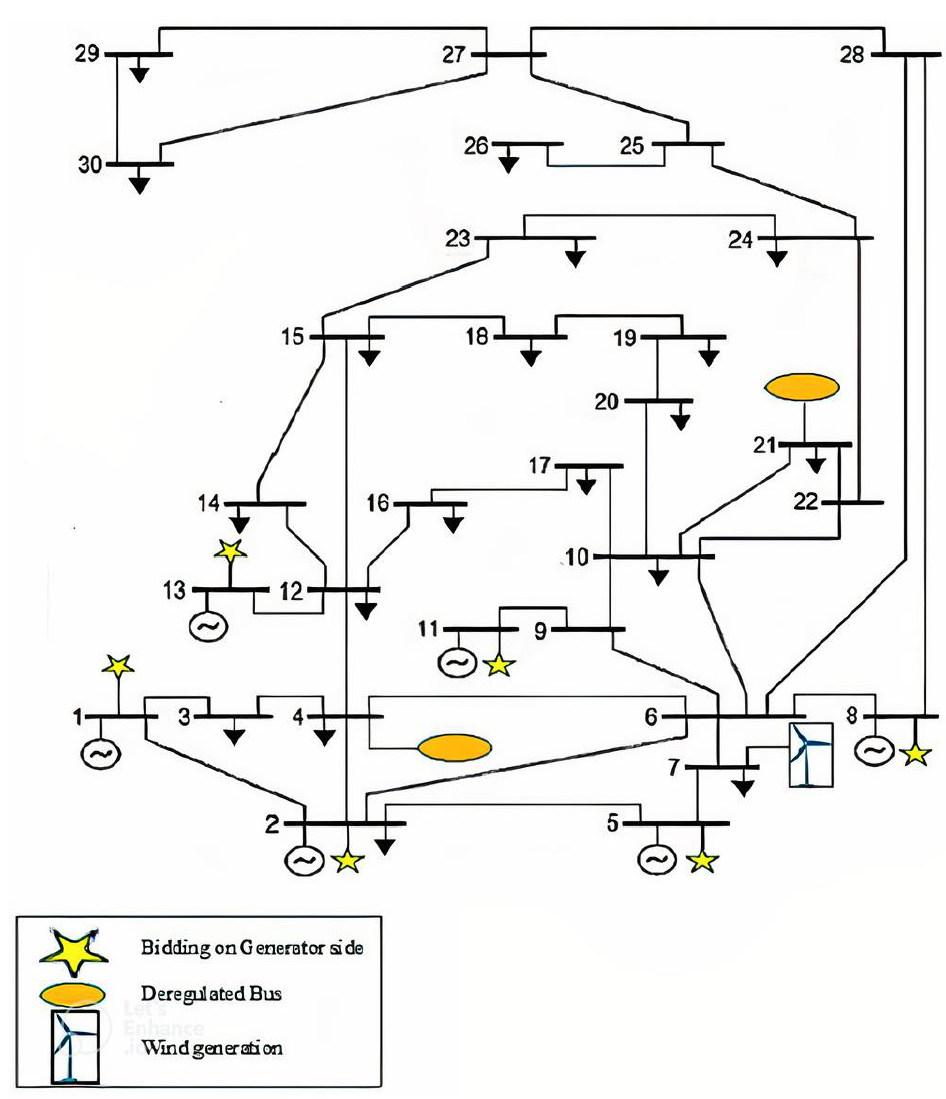
Figure 3. Single line diagram of modified IEEE 30-bus system. Table 5. Calculation of revenue and generating costs with wind integration.